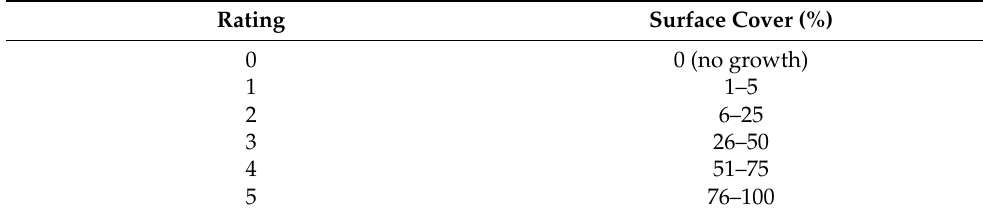
Table 1. Assessment system used to determine the fungal surface growth on